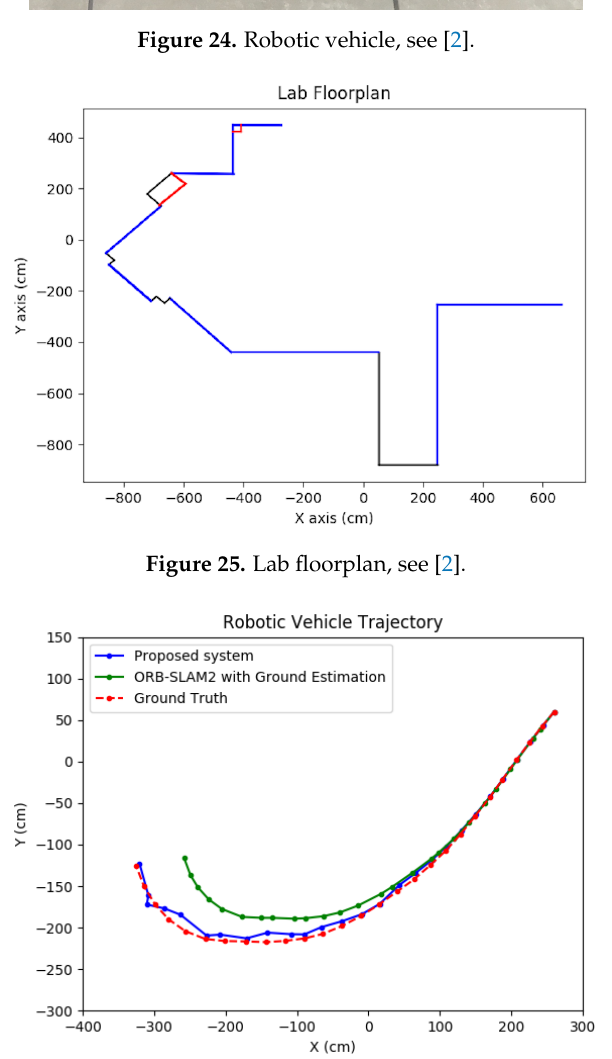
Figure 26. Real-world test